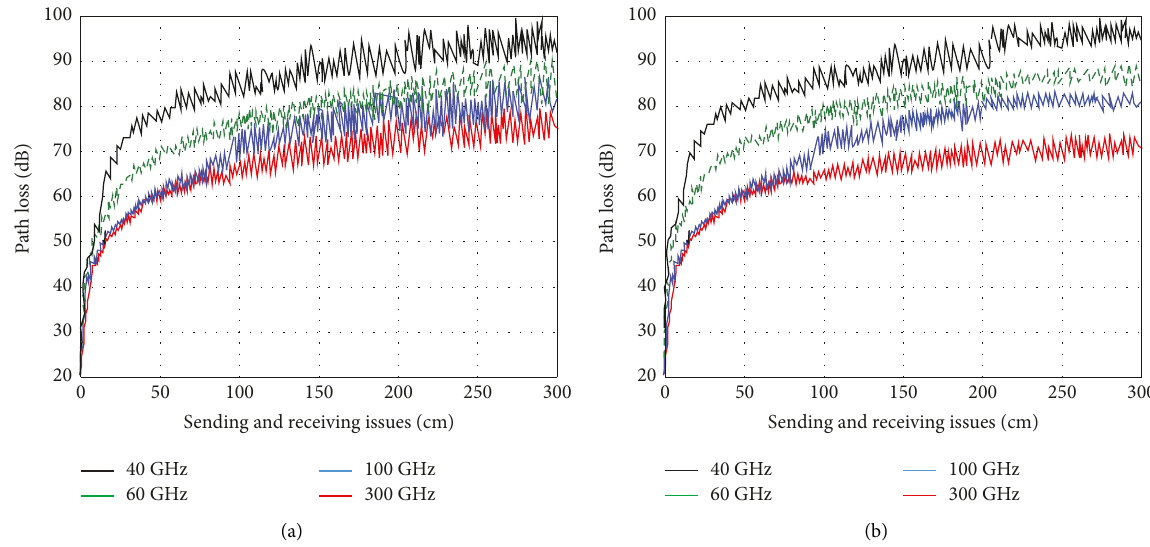
Figure 6: Comparison of path loss at different frequencies. (a) Comparison of path loss at different frequencies (horizontal). (b) Comparison of path loss at different frequencies